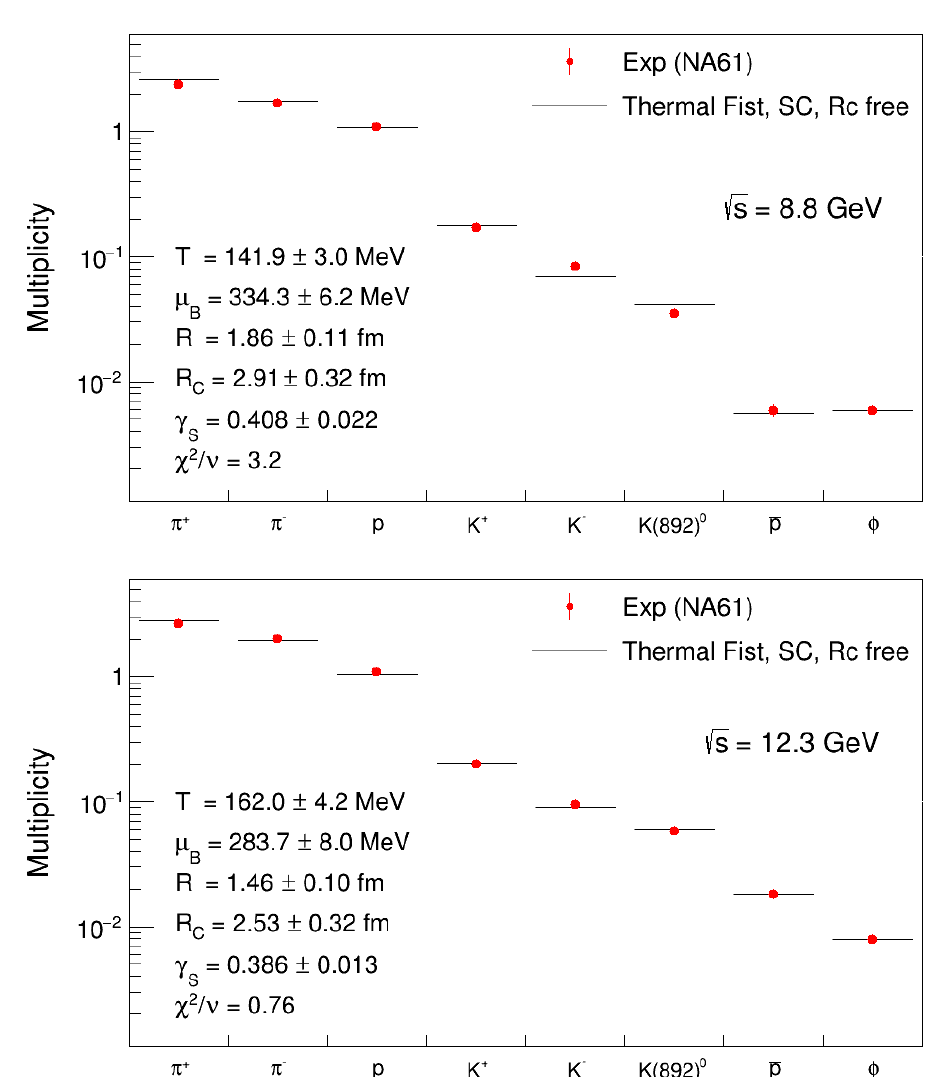
Figure 1. Results of statistical hadronization model fit (lines) to the experimental yields (full dots) of hadrons from p + p at √ s = 8.8 GeV (upper panel) and 12.3 GeV (lower